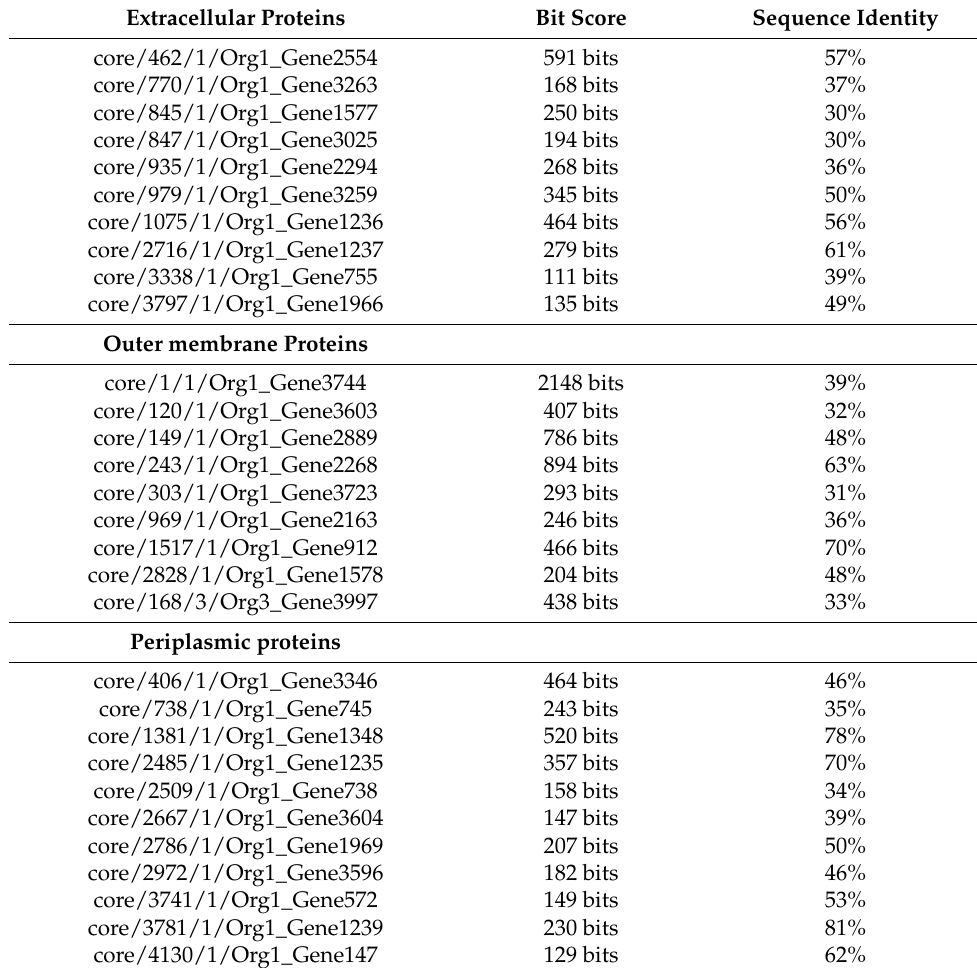
Table 2. Virulent proteins with exposed surface